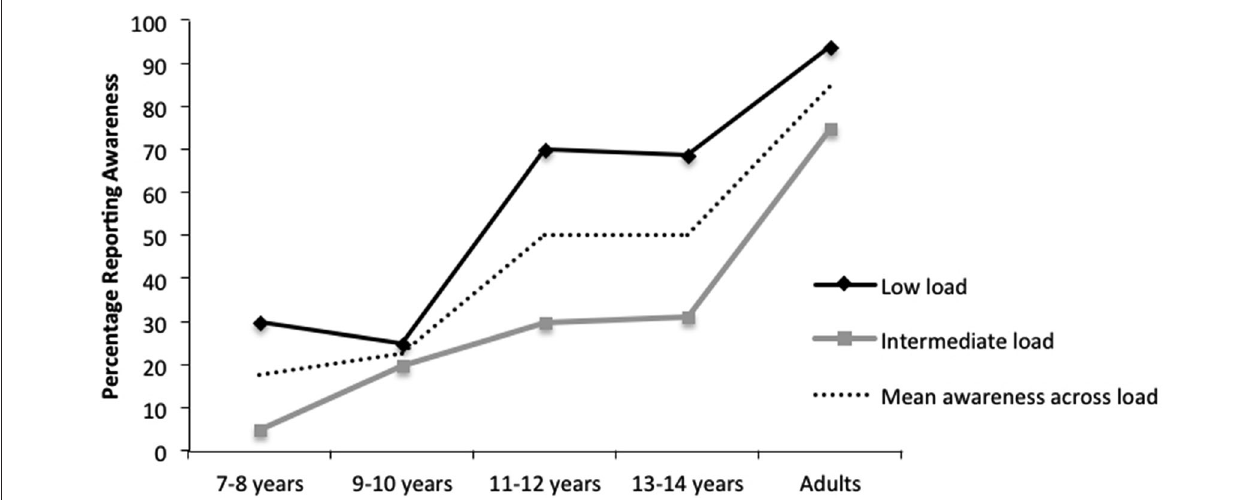
FIGURE 2 | Percentage of reported awareness of a peripheral critical stimulus (central target) as a function of perceptual load (low vs. intermediate) and age group, N = 188, in Experiment 1 .